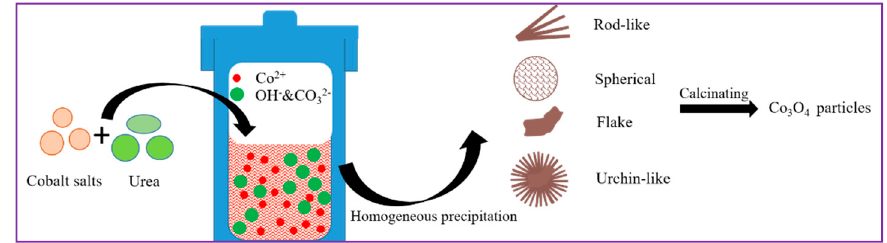
Figure 1. Schematic illustrations of synthesizing precursors and calcinated products.